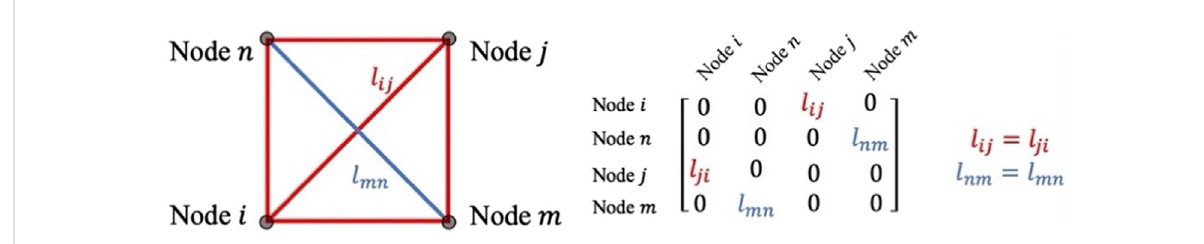
FIGURE 3 Bracing directions and associate link predictions in a grid cell.